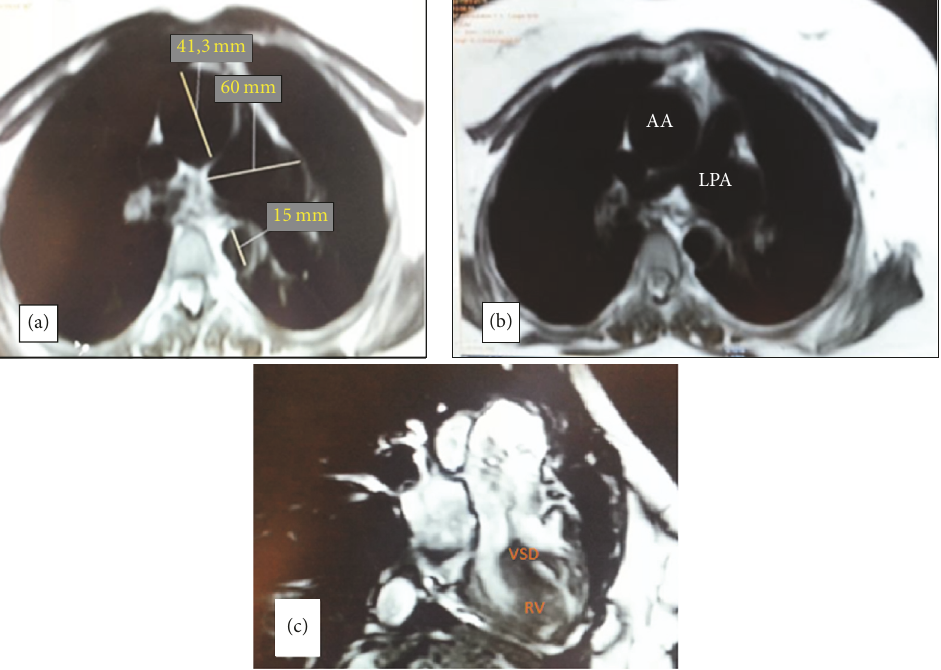
Figure 5: (a and b) The transverse section of a chest MRI showed an aneurysmal change in the left pulmonary artery. Dimensions of the main and right pulmonary arteries were normal. The ascending aorta was also mildly dilated. (c) Cine cardiac magnetic resonance image showing lesions of Fallot’s Tetralogy (VSD, overriding aorta, and dilated right